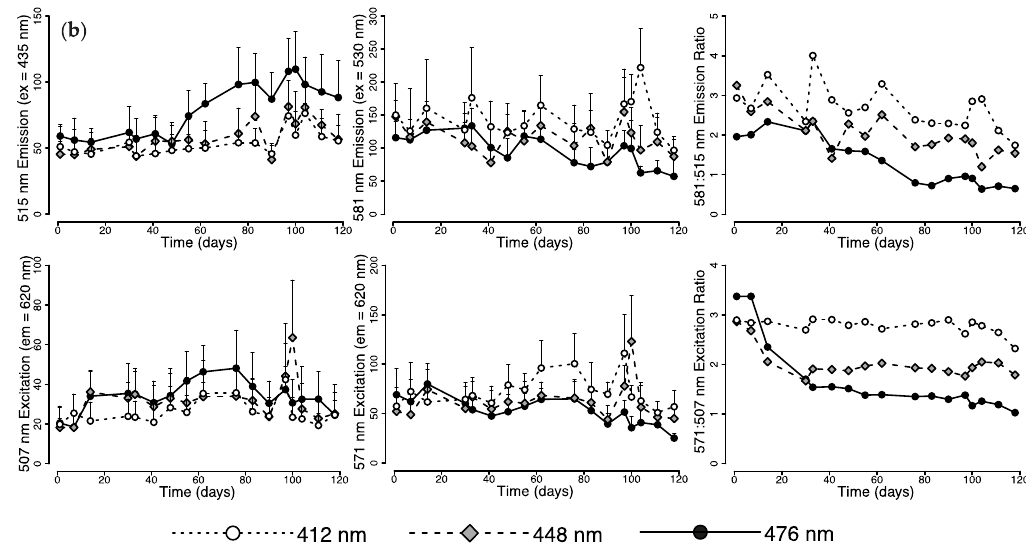
Figure 1. In vivo fluorescence of M. cavernosa and Echinophyllia sp. during 123 days exposure to 476, 448 and 412 nm light. ( a ) M. cavernosa : green emission (514 nm) measured with 450 nm excitation, red emission (582 nm) with 530 nm excitation, and 507 and 571 nm excitation measured for 620 nm emission; ( b ) Echinophyllia sp.: green emission (515 nm) measured with 435 nm excitation, red emission (581 nm) measured with 530 nm excitation, and 507 and 571 nm excitation measured for 620 nm emission. Mean + Standard Deviation (S.D.), n = 6.